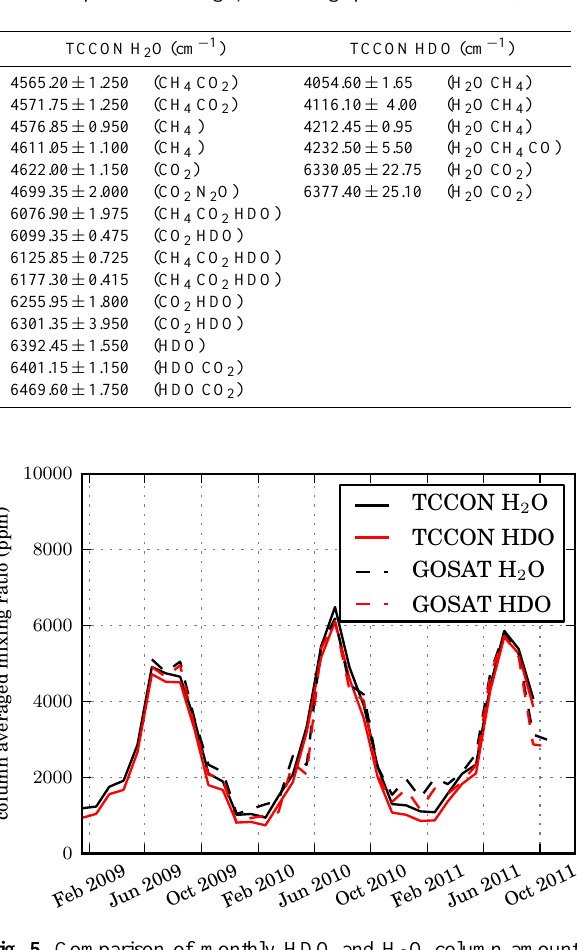
Table 2. Retrieval windows for HDO and H 2 O used for TCCON (center frequencies ± range, interfering species in brackets).